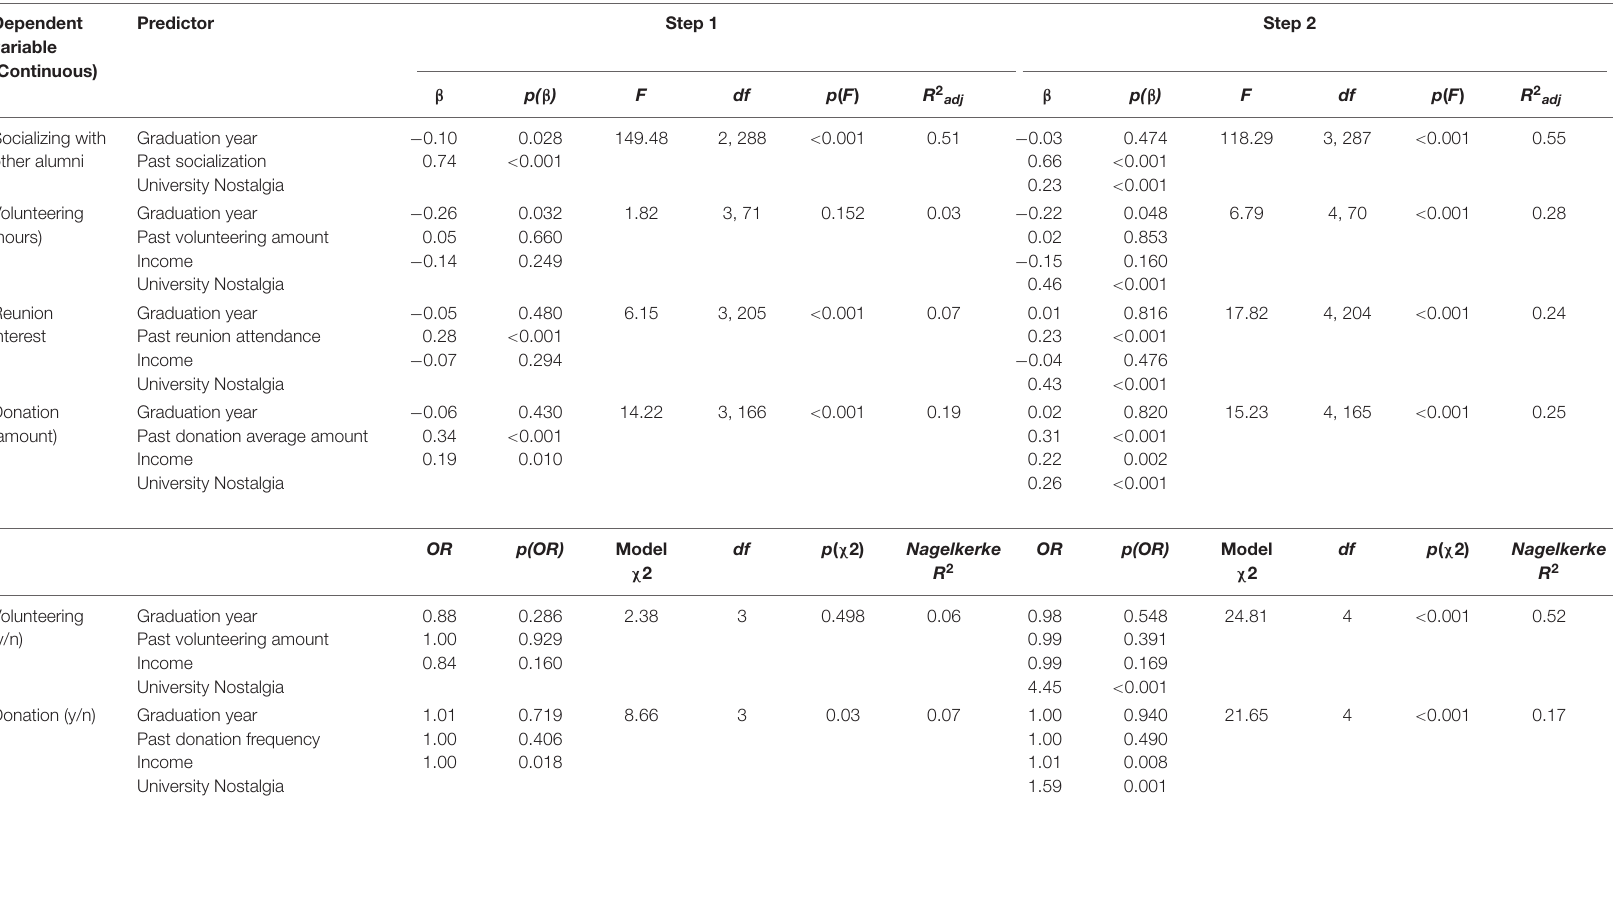
TABLE 3 | Regression models for study 1 alumni engagement